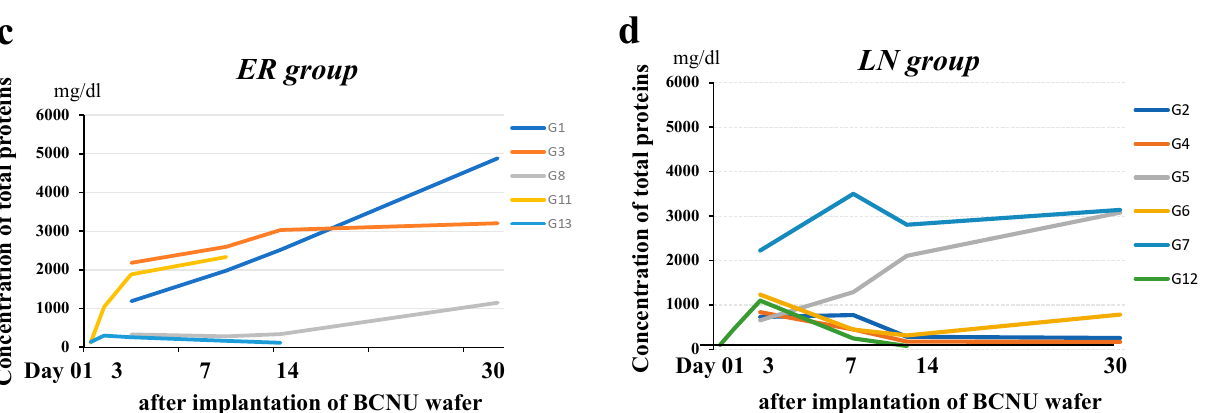
Figure 6. Time course of protein concentration in the resection cavity. ( a ) Protein concentrations